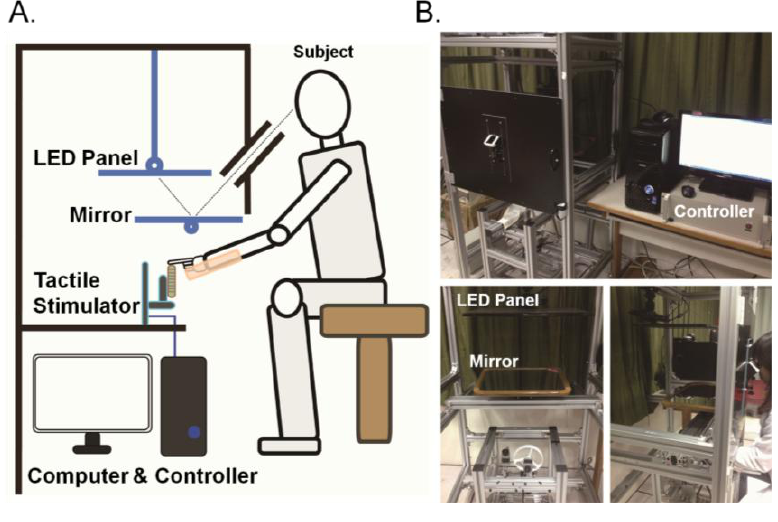
Figure 2. The apparatus for characterizing visual-tactile motion integration. ( A ) The schematic diagram of the setup that uses a mirror to achieve spatially aligned presentation of visual and tactile stimulation. ( B ) Three views of the apparatus and the control module.